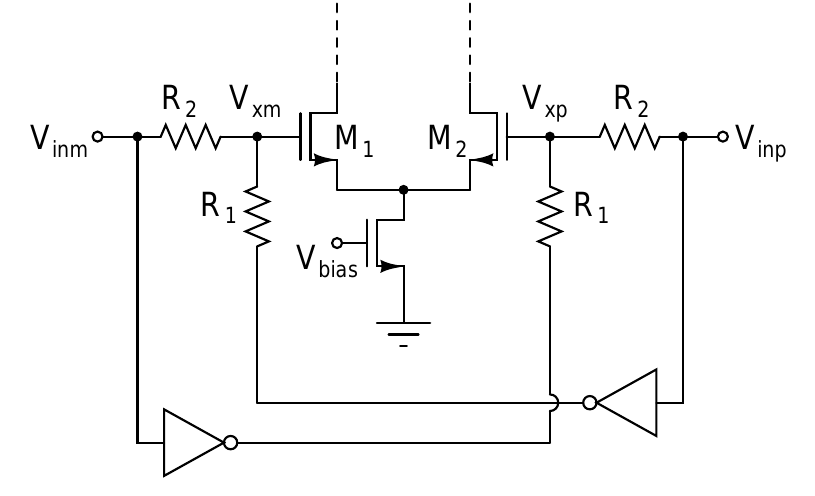
Figure 10. Common-mode cancellation